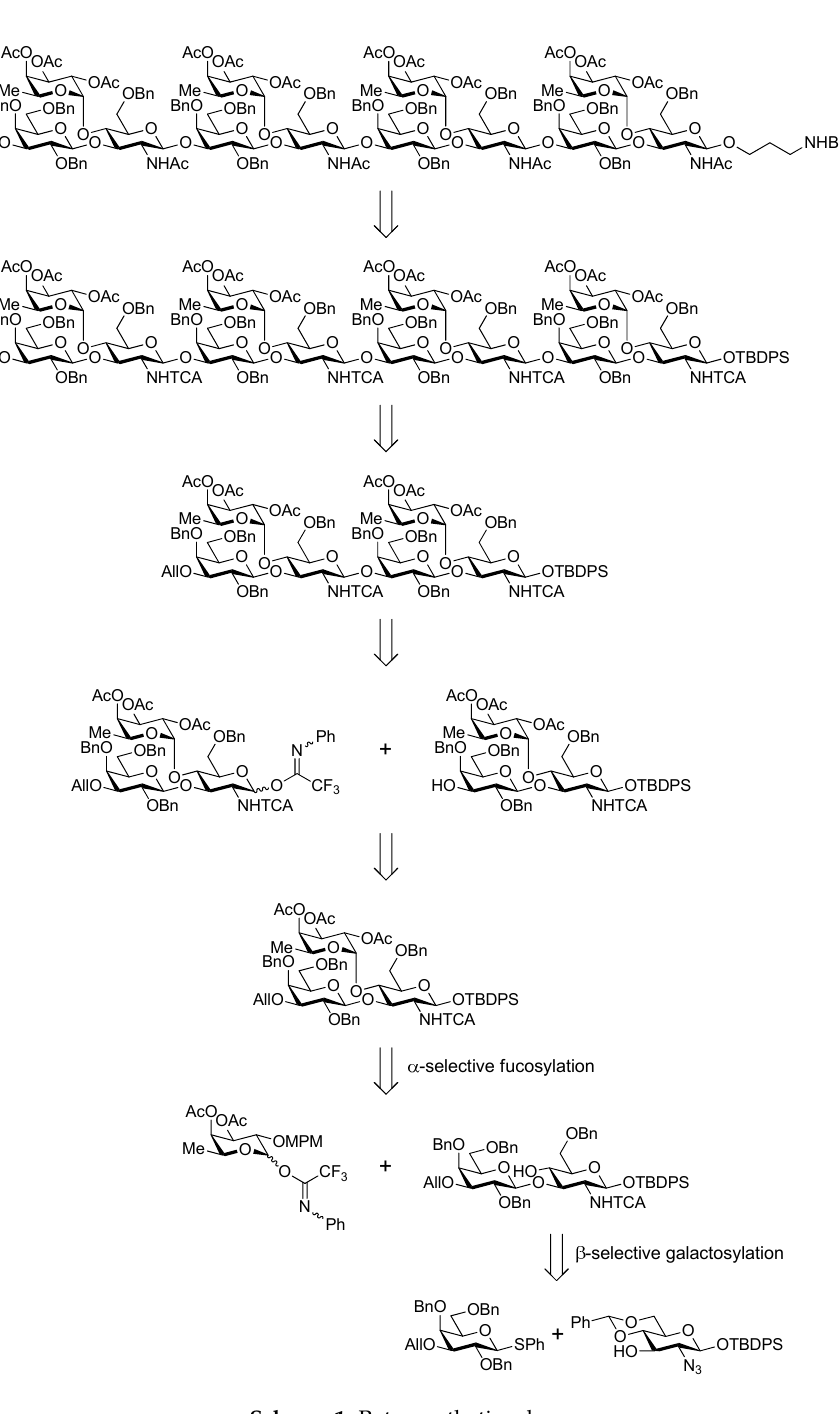
Scheme 1. Retrosynthetic scheme.